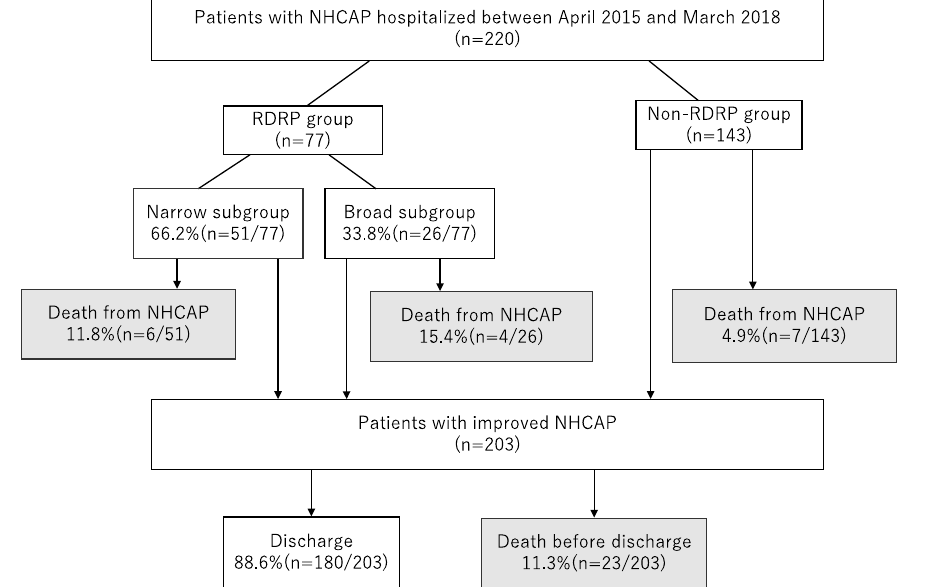
Figure 1 Flowchart showing the participant selection process. RDRP group, patients with risk factors for drug-resistant pathogen infection; non-RDRP, patients without risk factors for drug-resistant pathogen infection; narrow subgroup, patients treated with narrow-spectrum antimicrobials for NHCAP; broad subgroup, patients treated with broad-spectrum antimicrobials for NHCAP. NHCAP, nursing and